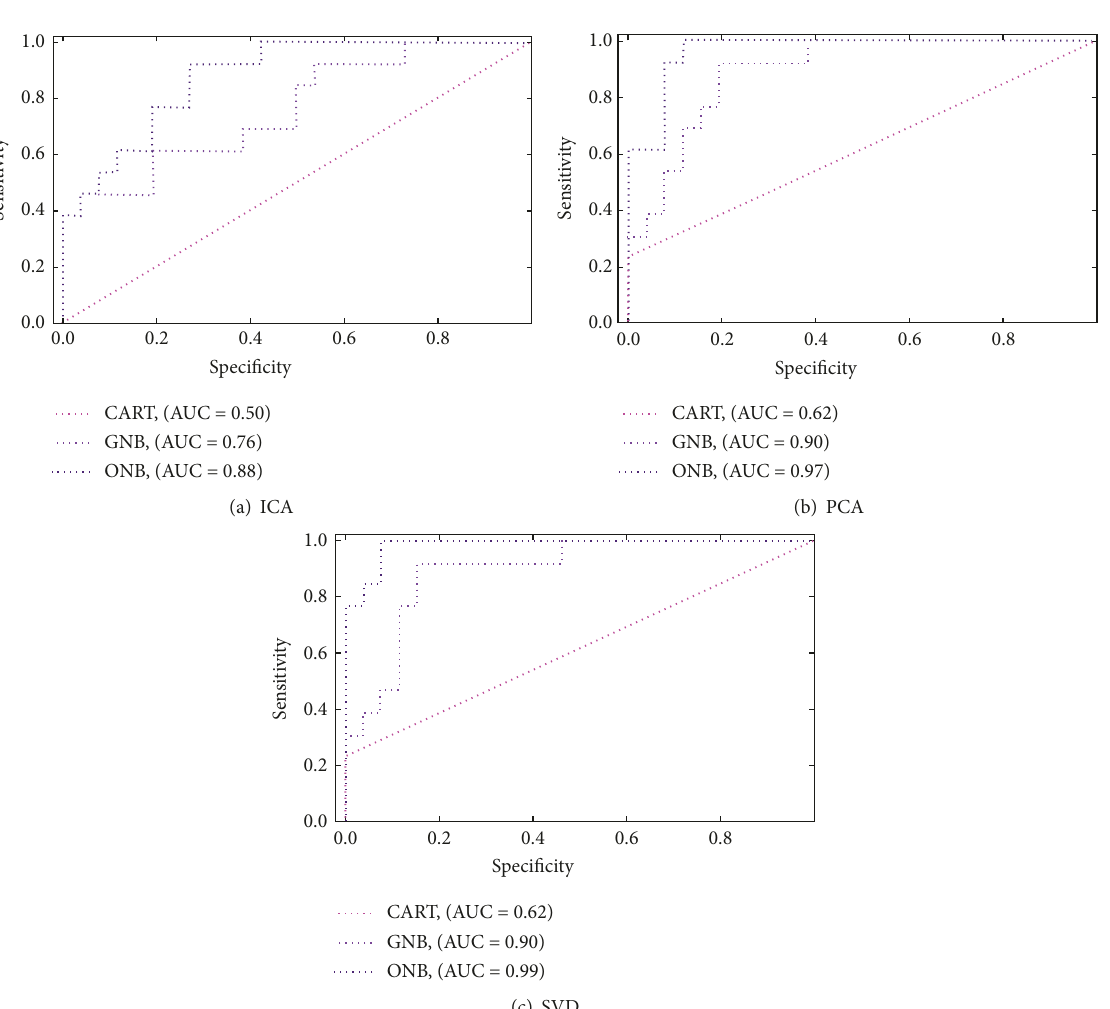
Figure 20: ROC curves for classification using the CART, Gaussian, and optimized Naive-Bayes with ICA, PCA, and SVD data reduction